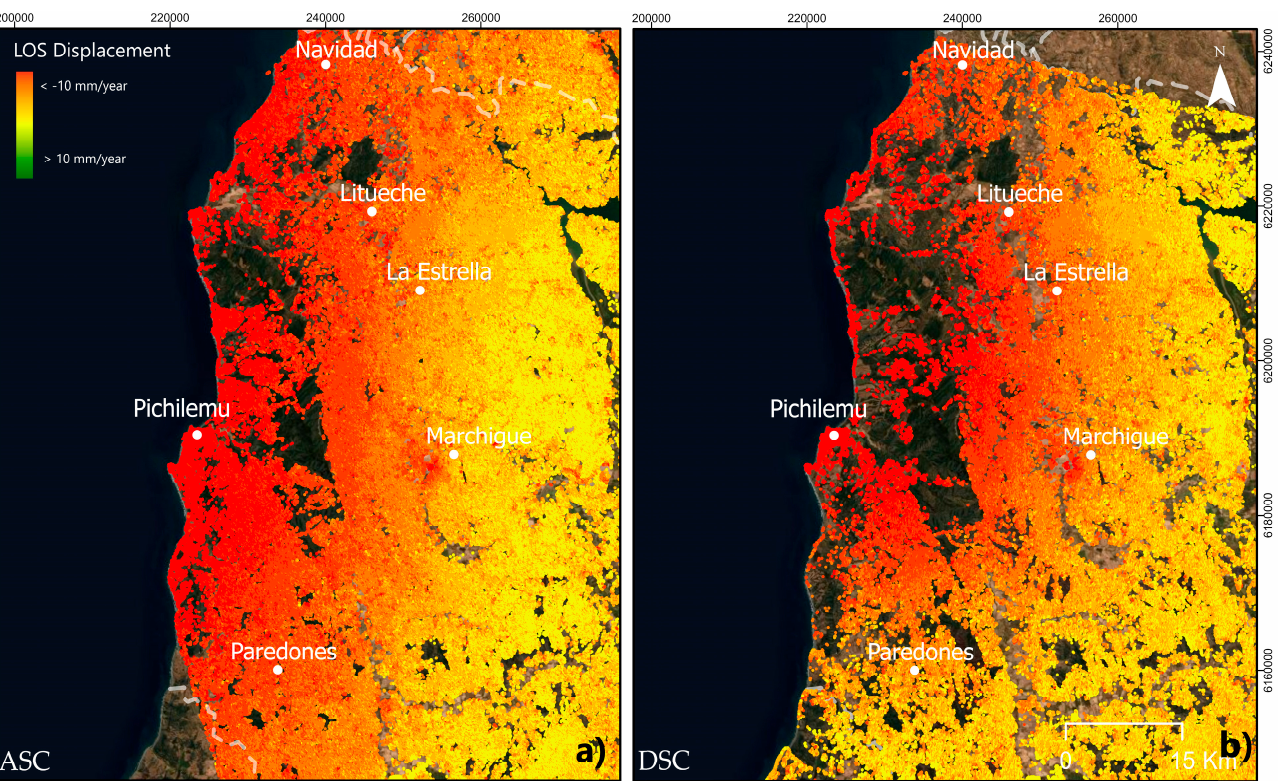
Figure 6. Land displacement maps in subsidence area (mm/year) for ( a ) ascending orbit 18ASC and ( b ) descending orbit 156DSC. Small towns are evidenced by white points.